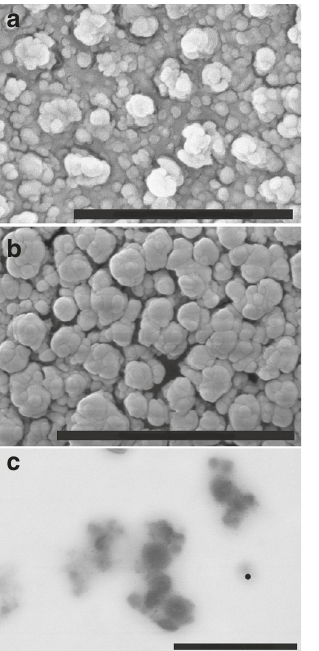
Fig. 8 Characterization of calcium oxalate precipitates formed in the presence of citrate (I). a , b Cryo-ESEM and c STEM image of calcium oxalate precipitates formed in the presence of 10 mM citrate in a , b titration experiments and c rapid mixing experiments. Scale bars : a , b 1 μ m; c 500 nm